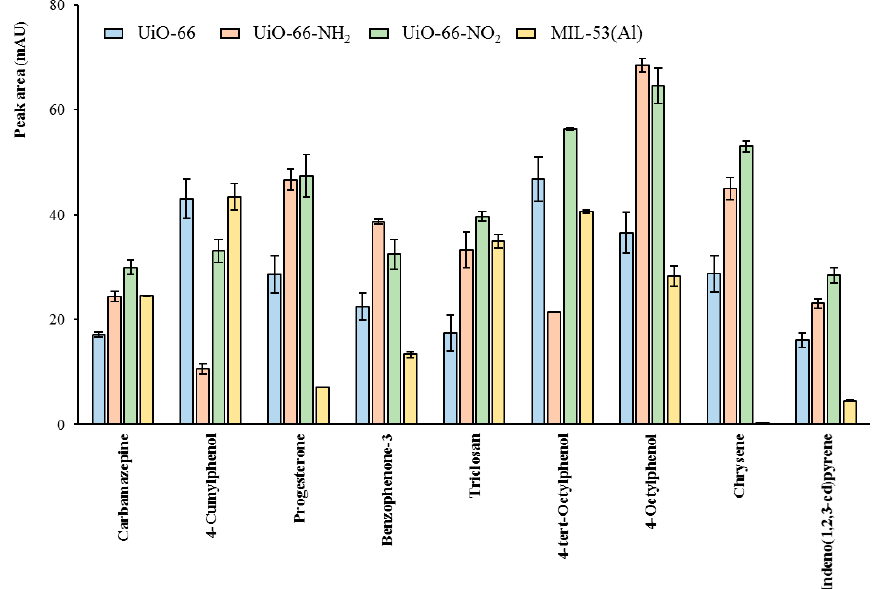
Figure 3. Comparison between the different MOFs used in terms of extraction efficiency with the optimum D- µ SPE-HPLC-DAD method. Fixed optimum conditions as described in the text. Experiments were carried out in triplicate.